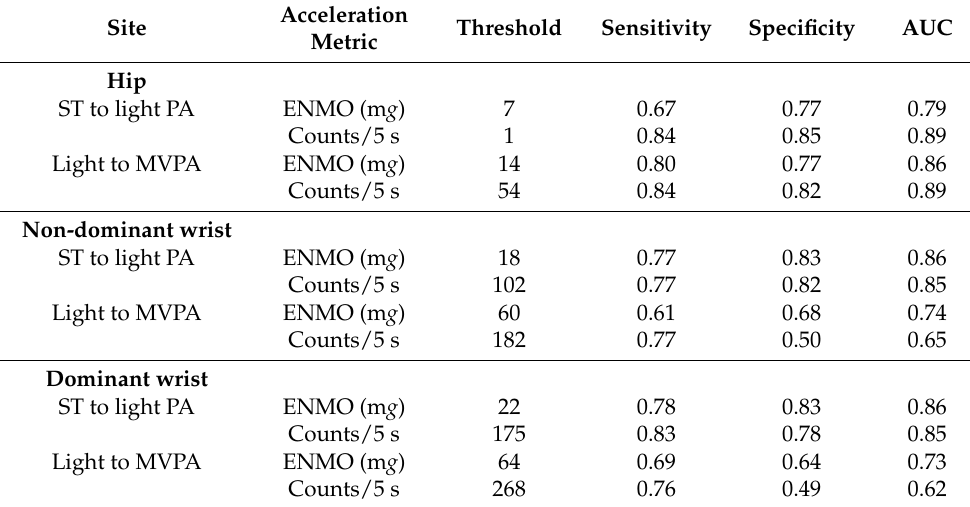
Table 4. Derived thresholds to classify ST, light, and MVPA intensities in the calibration sample (AREA).